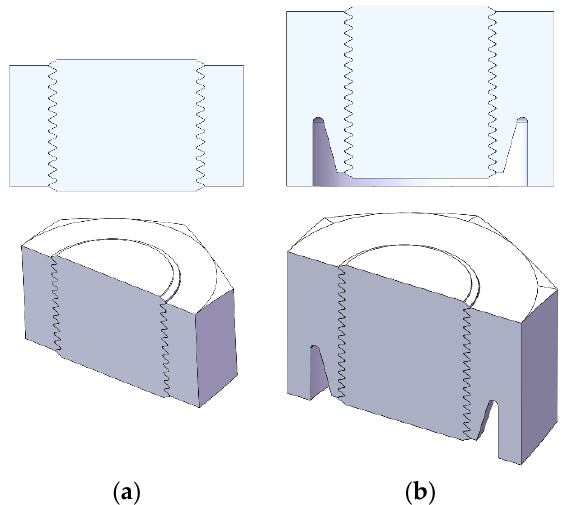
Figure 5. Sections through the analysed matrices: ( a ) normalised nut; ( b ) modified nut with the designed notch.